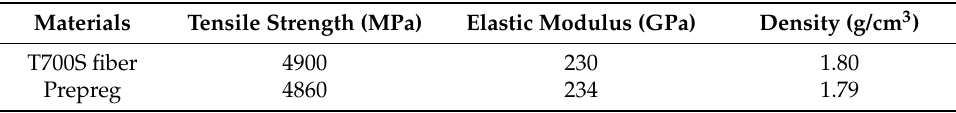
Table 1. Mechanical properties of T700S fiber and its